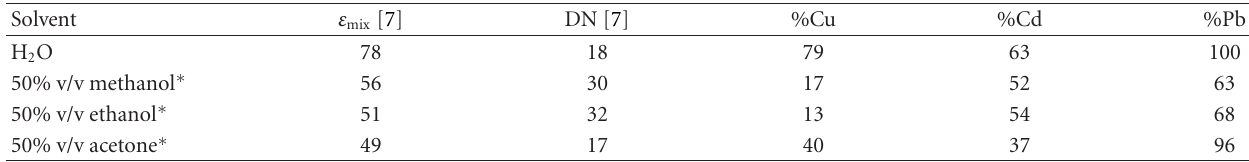
Table 1: Percentage of metal ion uptake from di ff erent mixed solvents.